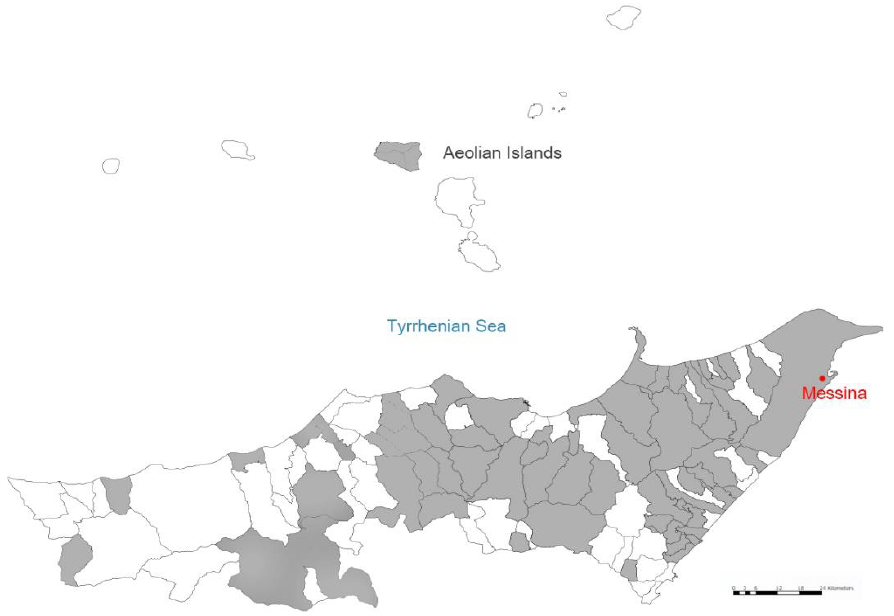
Figure 2. Territorial area covered by the SEAP in the province of